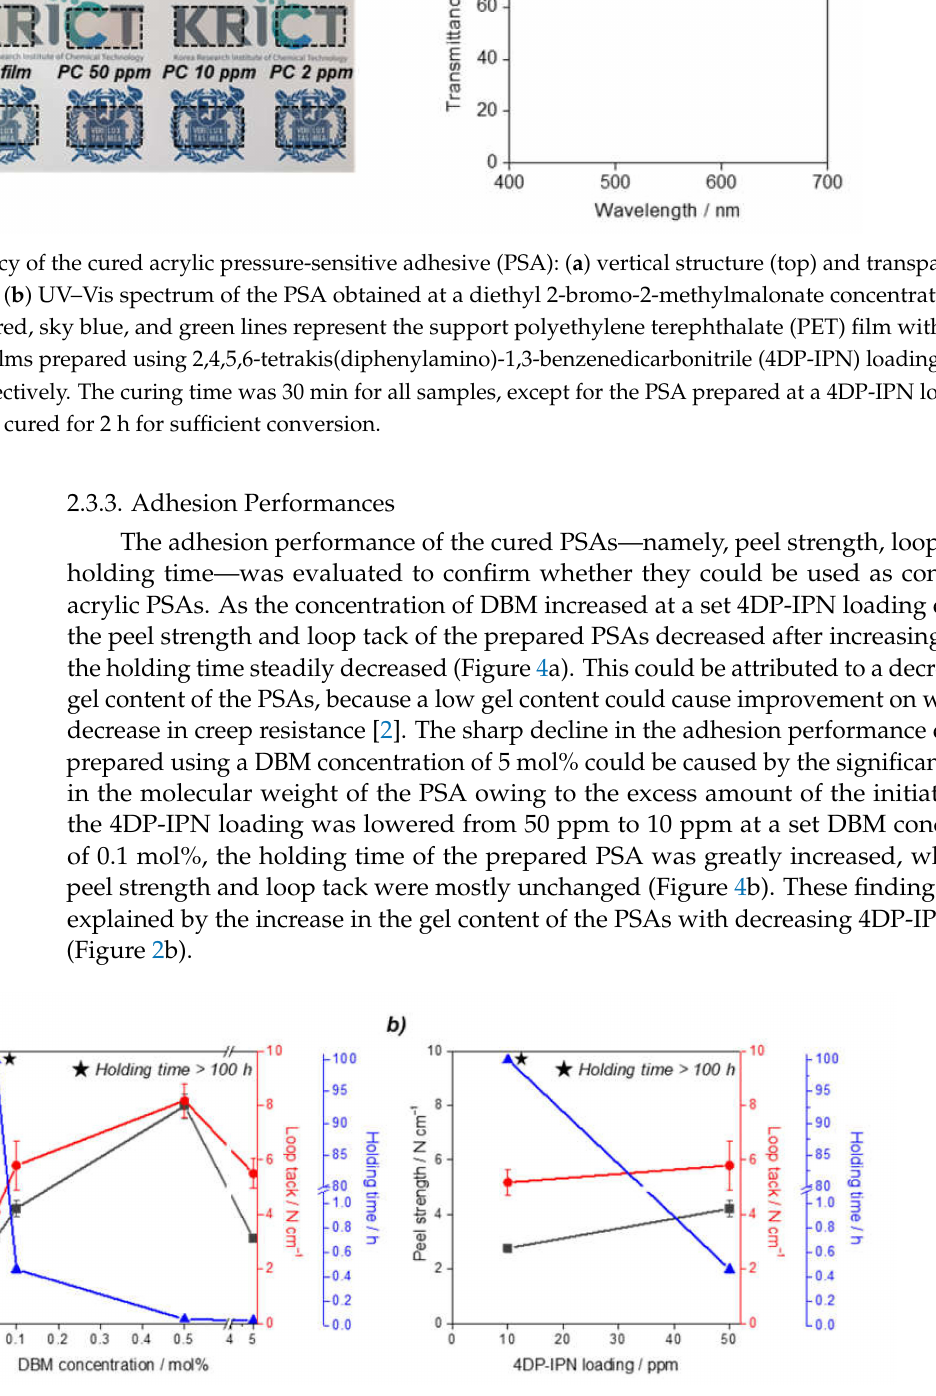
Figure 4. Adhesion performances of cured acrylic pressure-sensitive adhesives obtained using different: ( a ) diethyl 2-bromo- 2-methylmalonate (DBM) concentrations (the 2,4,5,6-tetrakis(diphenylamino)-1,3-benzenedicarbonitrile (4DP-IPN) loading and curing time were 50 ppm and 30 min, respectively) and ( b ) 4DP-IPN loadings (the DBM concentration and curing time were 0.1 mol% and 30 min, respectively). The gray squares, red circles, and blue triangles represent the peel strength, loop tack, and holding time,